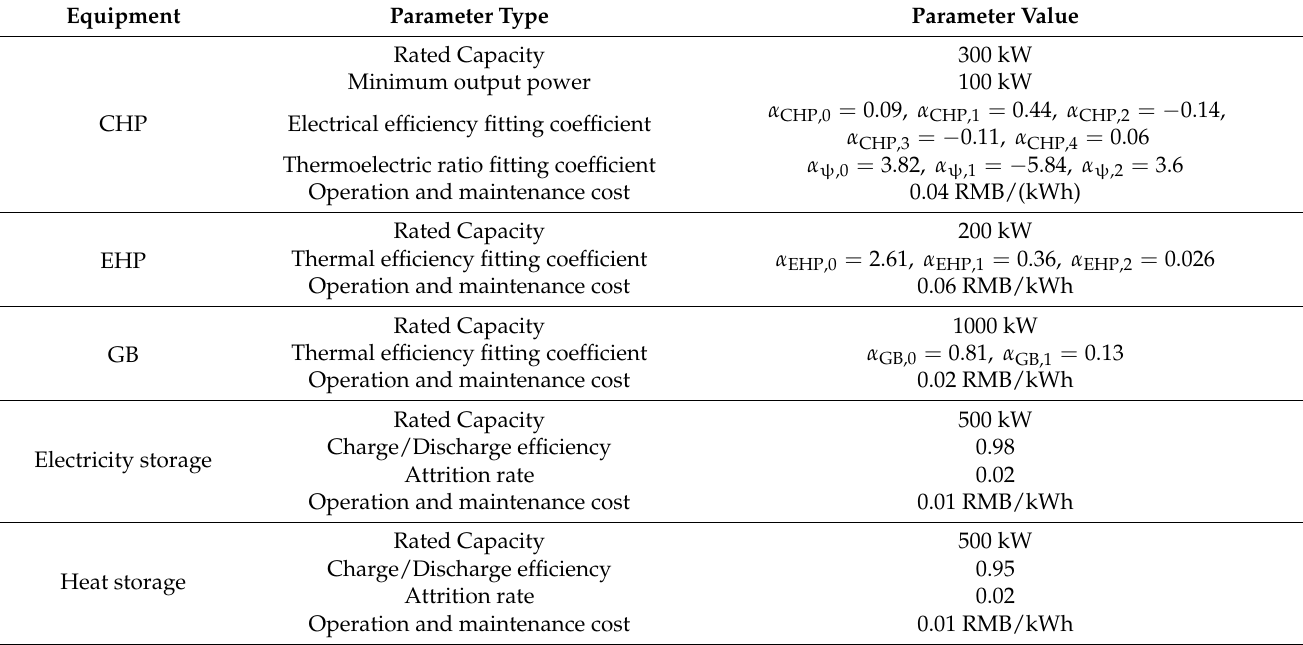
Table A1. The equipment